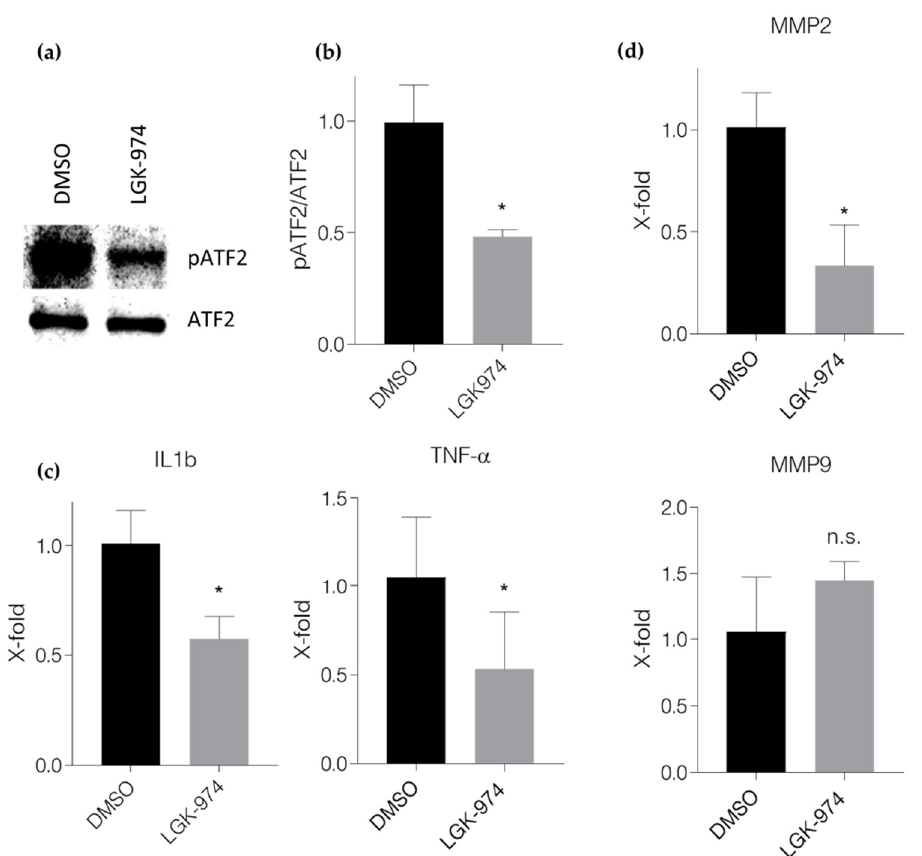
Figure 5. LGK-974 inhibits non-canonical Wnt signaling in monocytes/macrophages and leads to a reduced inflammatory character. ( a ) representative Western blots of pATF2 expression in monocytes/macrophages stimulated with supernatant of heart muscle cells that were cultured under hypoxic conditions in the presents or absence of LGK-974 and ( b ) quantification. ( c ) Expression of the inflammatory markers TNF α and IL1 β and ( d ) the matrix metalloproteinases MMP2 (top) and MMP9 (bottom) measured by qPCR in monocytes/macrophages stimulated with supernatant of heart muscle cells that were cultured under hypoxic conditions in the presents or absence of LGK-974. Results originate from three independent experiments. n.s.: not significant; *: p ≤ 0.05